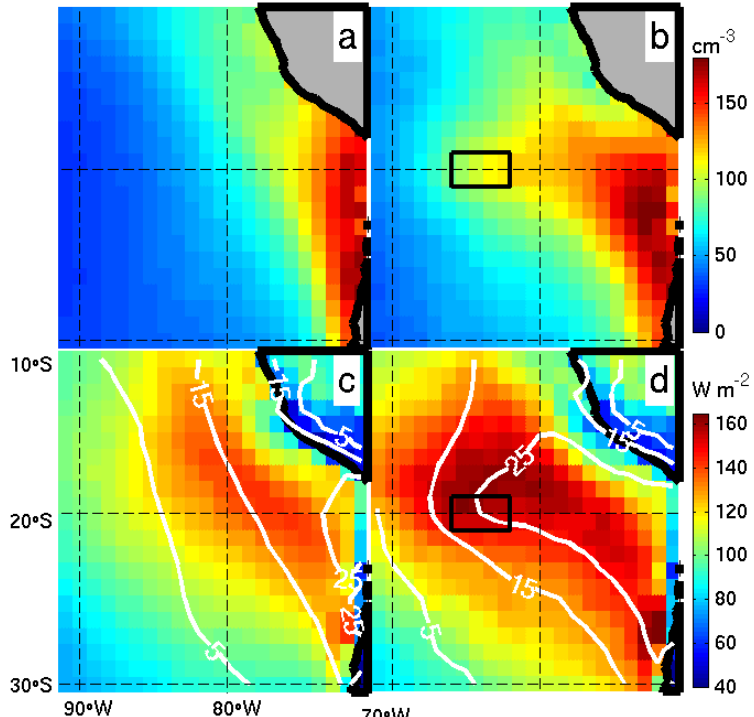
Fig. 1. MODIS time-mean cloud droplet concentration for years 2000–2008 ( N d ) from (a) all retrieved days and (b) days when N d averaged over the domain 19–21 ◦ S, 82–86 ◦ W is larger than 87cm − 3 (time mean plus standard deviation). Shaded colors in (c) show the diurnal mean estimate of reflected solar flux at the top of the atmosphere. The white contour lines are the time mean of the difference between the reflected solar flux and the same flux computed using the typical pristine marine N d (average time series of N d in the domain 30–40 ◦ S, 90–100 ◦ W), which is an estimate of the Twomey effect. The contour numbers indicate Wm − 2 of flux difference due to the increase in N d above typical marine values. (d) is the same as (c) , but composite on the same days as (b)